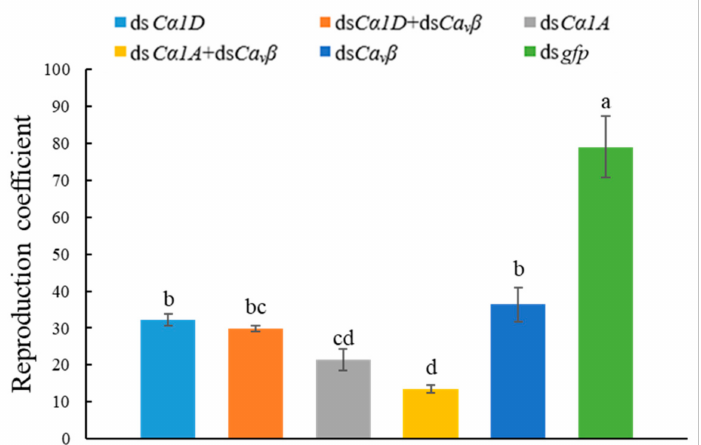
Figure 10. Silencing of Ca v β or HVA Ca v α 1 and co-silencing of Ca v β and HVA Ca v α 1 affected the reproduction rate of D. destructor . Nematodes that were treated with gfp dsRNA were used as controls. Different lowercase letters indicate a significant difference at the level of p < 0.05, as tested by Duncan’s new complex difference